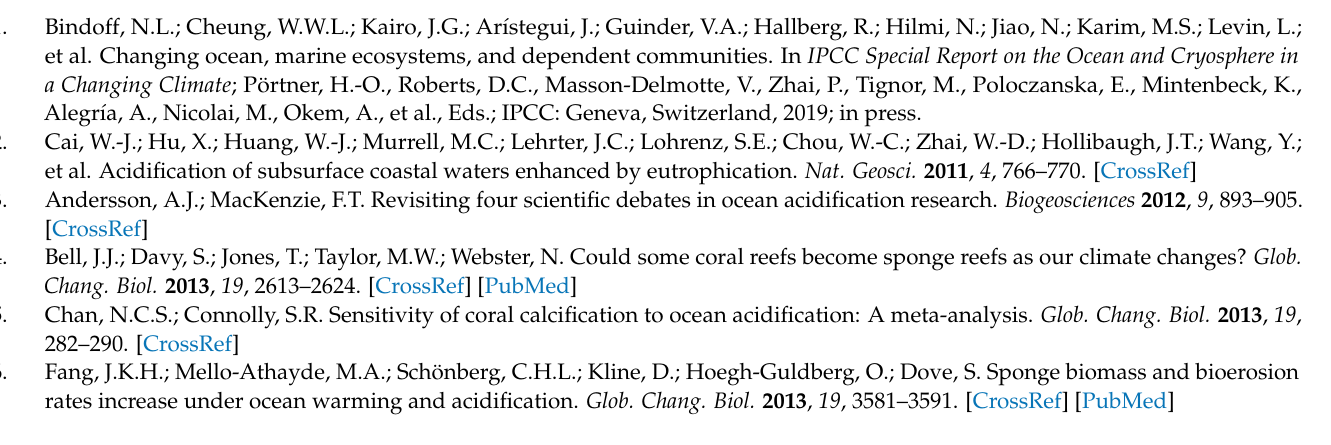
treatments. Table S1: Buoyant weight of corals, wet weight of algae, and biovolumes of sponges at the beginning and end of the experiment. Table S2: Seawater chemistry data measured in reservoir tanks and experimental aquaria. Temperature and Salinity were measured daily using a YSI multiprobe. Seawater samples for dissolved inorganic carbon (DIC) and total alkalinity (TA) were collected weekly for later laboratory